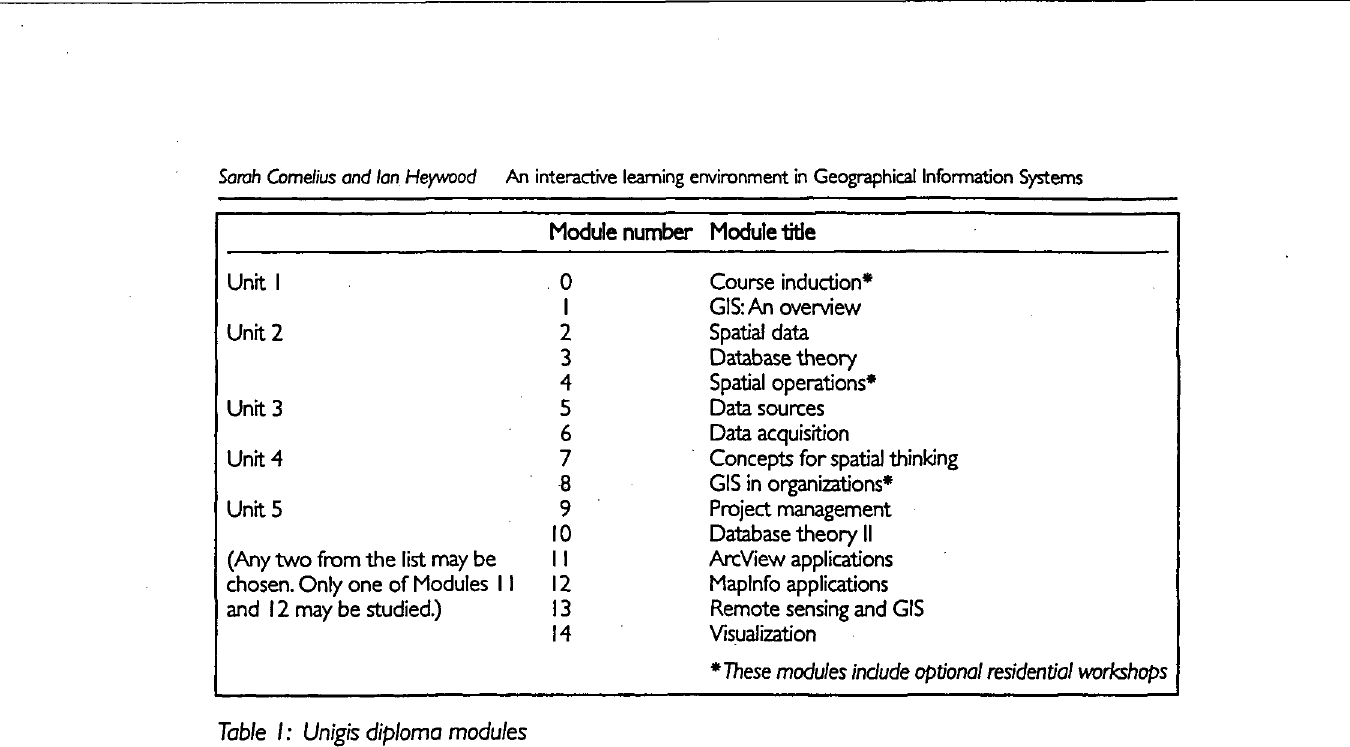
Table I: Unigis diploma